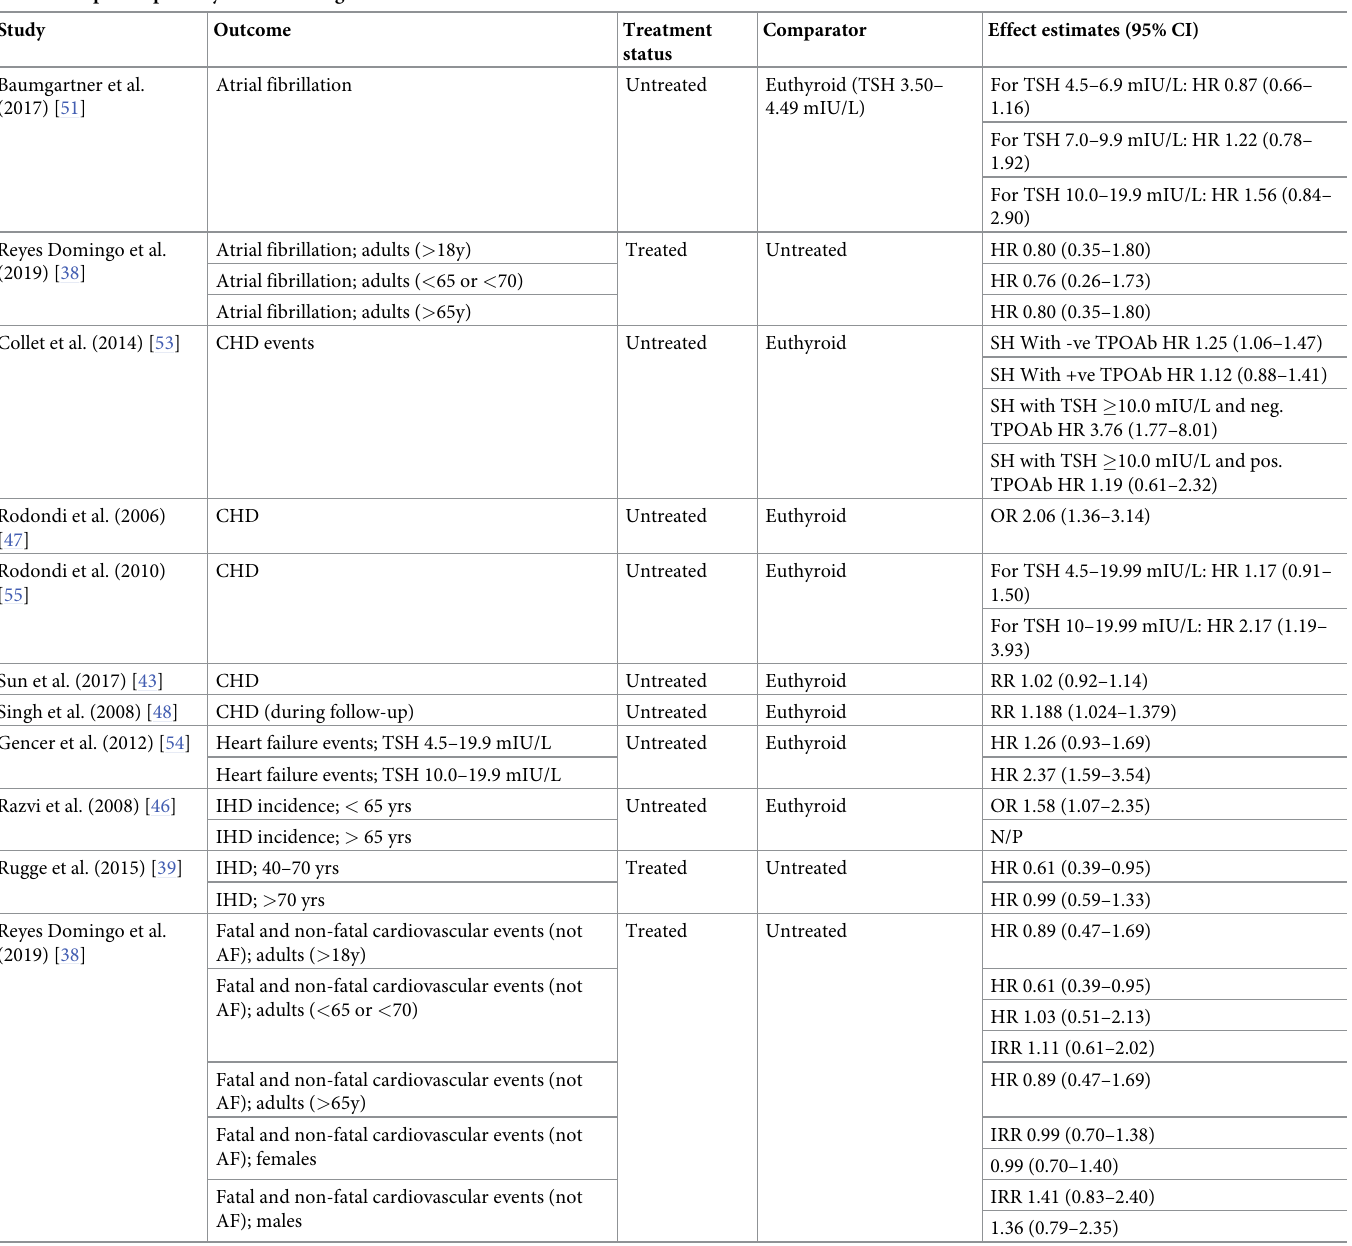
Table 4. Reported primary review findings on cardiovascular